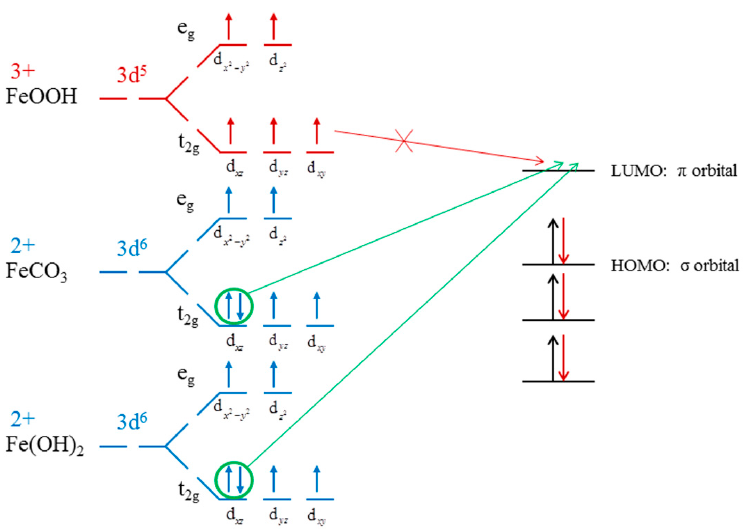
Figure 7. Coordination model of X − [28], calculated ligand fields of Fe 2+ in Fe(OH) 2 and FeCO 3 , and Fe 3+ in the ligand field of FeOOH [50].